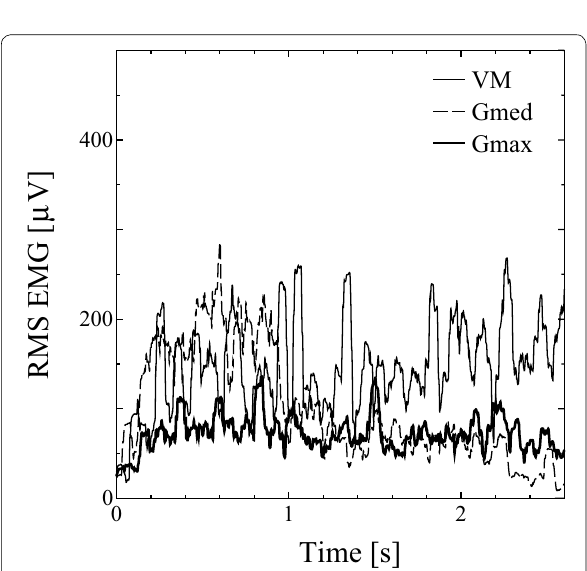
Fig. 23 RMS EMG of an ACL reconstructed subject during isotonic exercise. The target force was 120 N